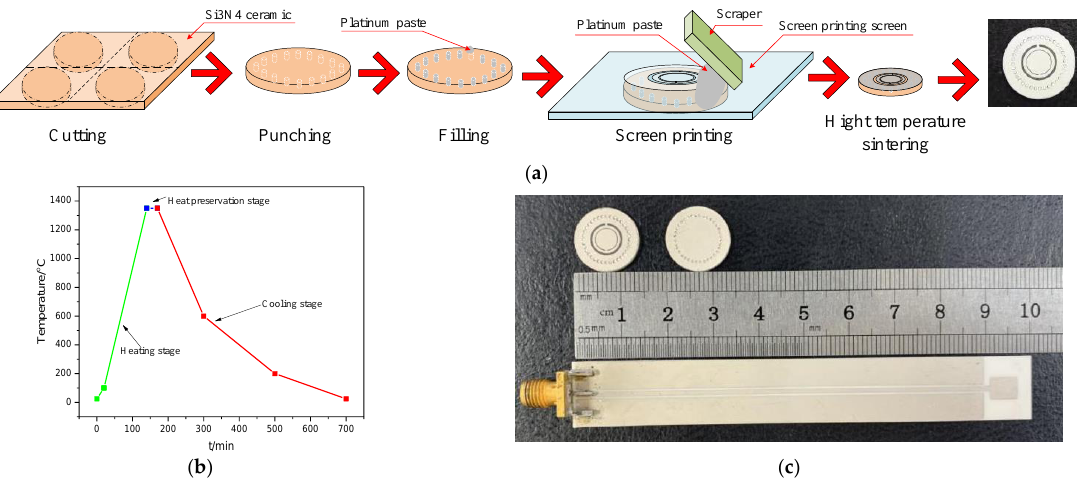
Figure 7. ( a ) Sensor manufacturing process, ( b ) sensor sintering curve, ( c ) high temperature sensor and inquiry antenna.